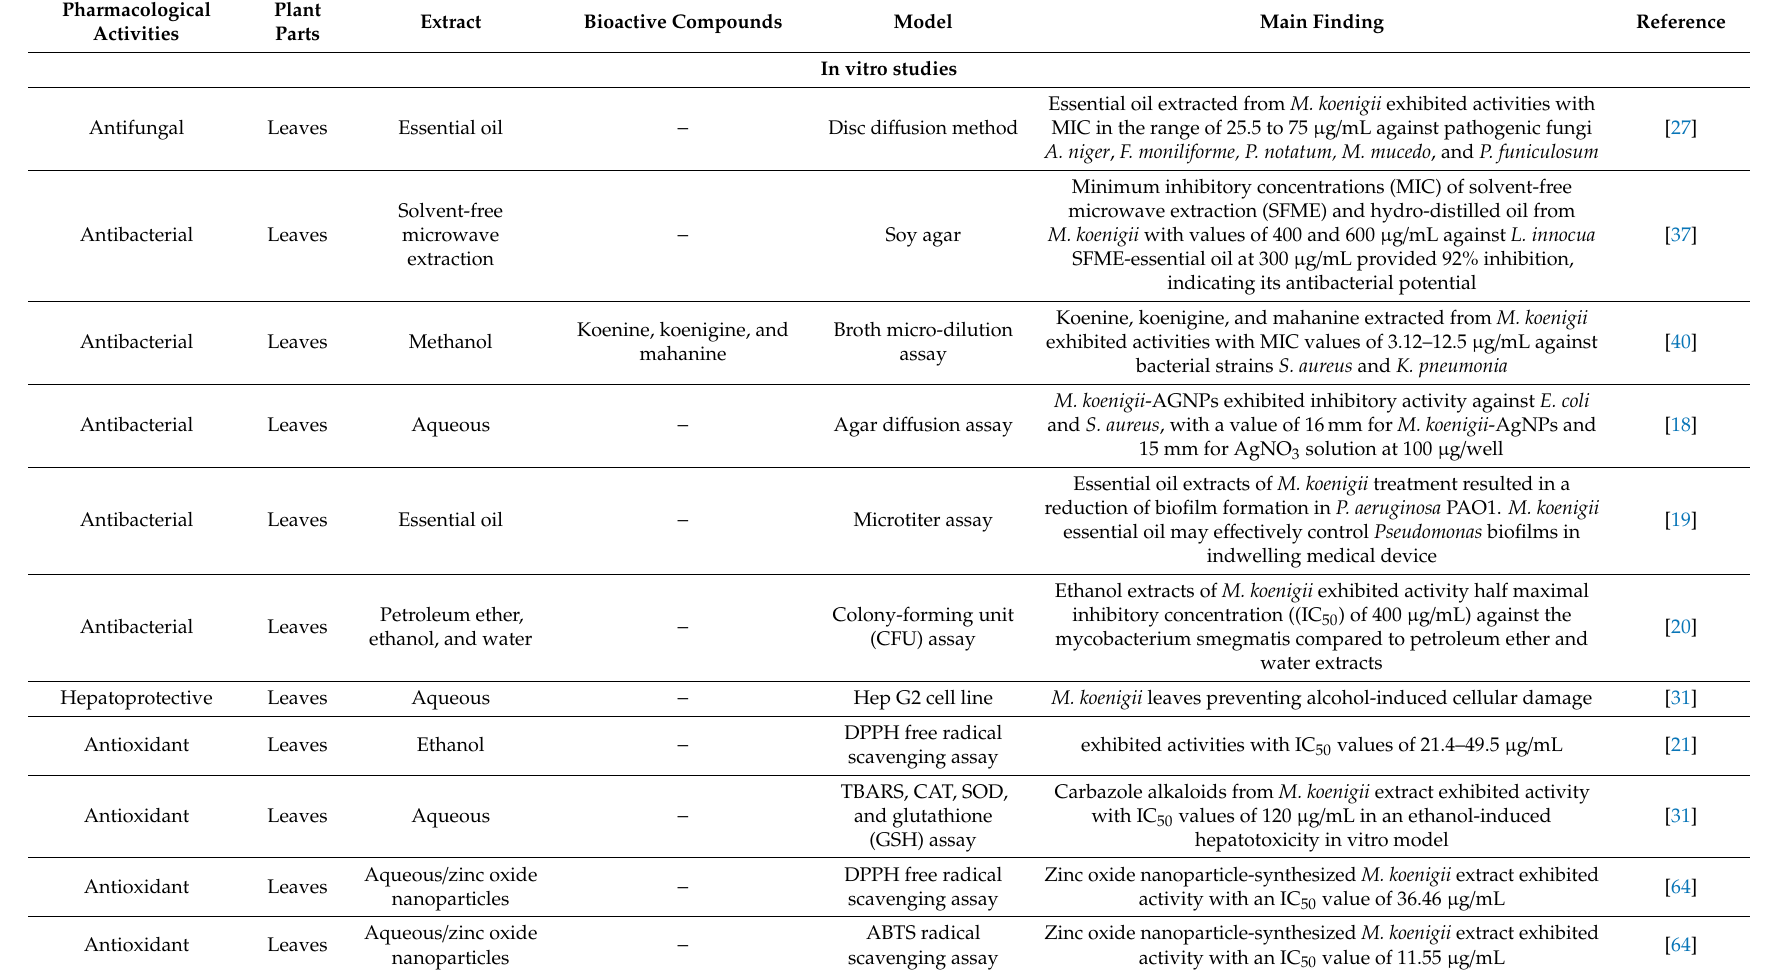
Table 3. An overview of the pharmacological activities of M. koenigii and its primary bioactive